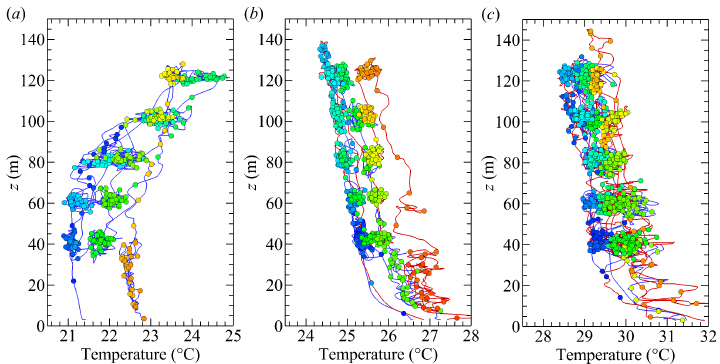
Figure 6. Profiles of altitude dependence of temperature measured by the two aircraft during ( a ) flight 1, ( b ) flight 2, and ( c ) flight 3. The symbols are spaced 5 s apart with the color of the symbols representing the position in time series (dark blue indicates the start of flight transitioning to red towards the end of flight). The blue lines indicate measurements made by BC5A and the red lines indicate measurements made by